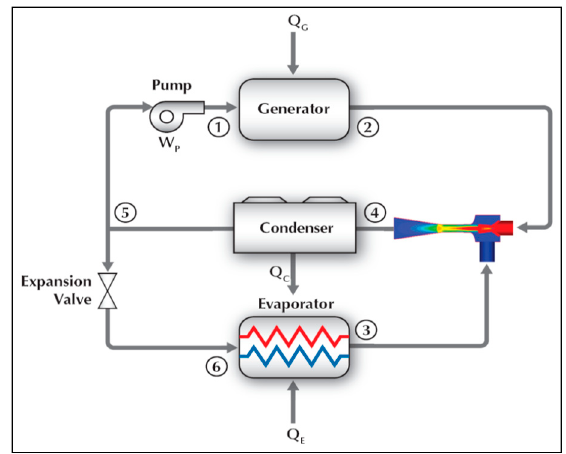
Figure 26. Schematic representation of a conventional ejector refrigeration system (ERS).